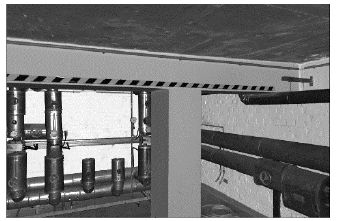
Figure 5. The central perspective synthetic image.